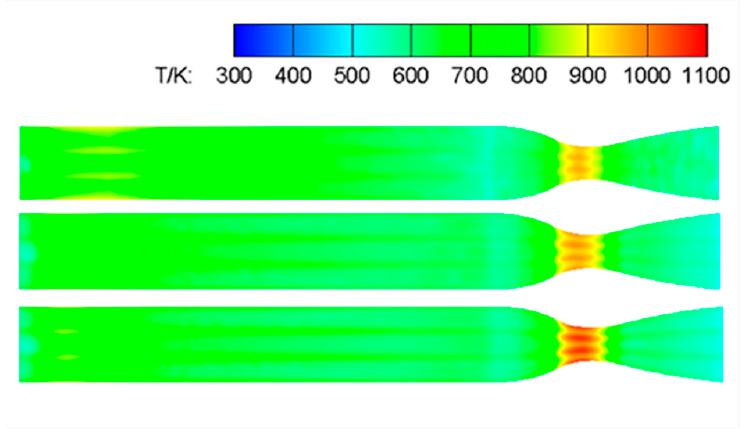
Figure 18. Temperature contour on the inner wall of rib width under 1.5 mm ( top ), 2.0 mm ( middle ), and 2.5 mm ( bottom ).